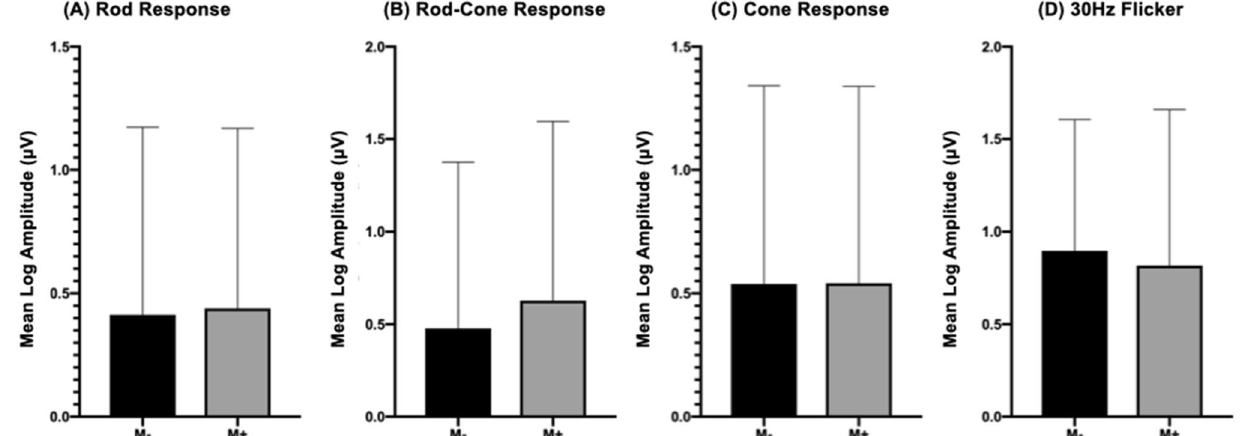
Figure 2. Different electroretinography response amplitudes of groups with or without macular involvement. ( A ) Mean log amplitudes of rod response were 0.413 and 0.440 in group without and with macular involvement, respectively. ( B ) Mean log amplitudes of rod-cone response were 0.478 and 0.629 in group without and with macular involvement, respectively. ( C ) Mean log amplitudes of cone responses were 0.538 and 0.541 in group without and with macular involvement, respectively. ( D ) Mean log amplitudes of 30 Hz flicker were 0.897 and 0.818 in group without and with macular involvement, respectively.* p < 0.05; ** p < 0.01 using unpaired t-test.